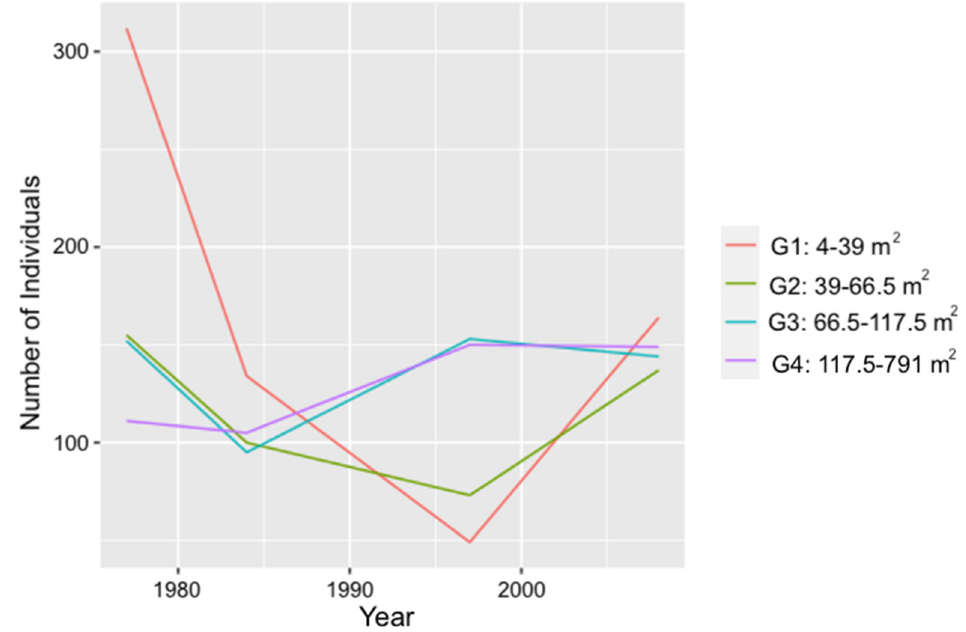
Figure 6. Changes in the number of individuals per shrub size class Juniperus communis L. from 1977 to 2008 in Barranco de San Juan (Sierra Nevada, Spain). The largest shrub size classes (G4, G3, and G2) suffered the lowest declines after the fire, while the smallest size class (G1) lost the greatest number of individuals. The fire occurred in 1983, the Natural Park was declared in 1989, and the National Park was declared in 1999.